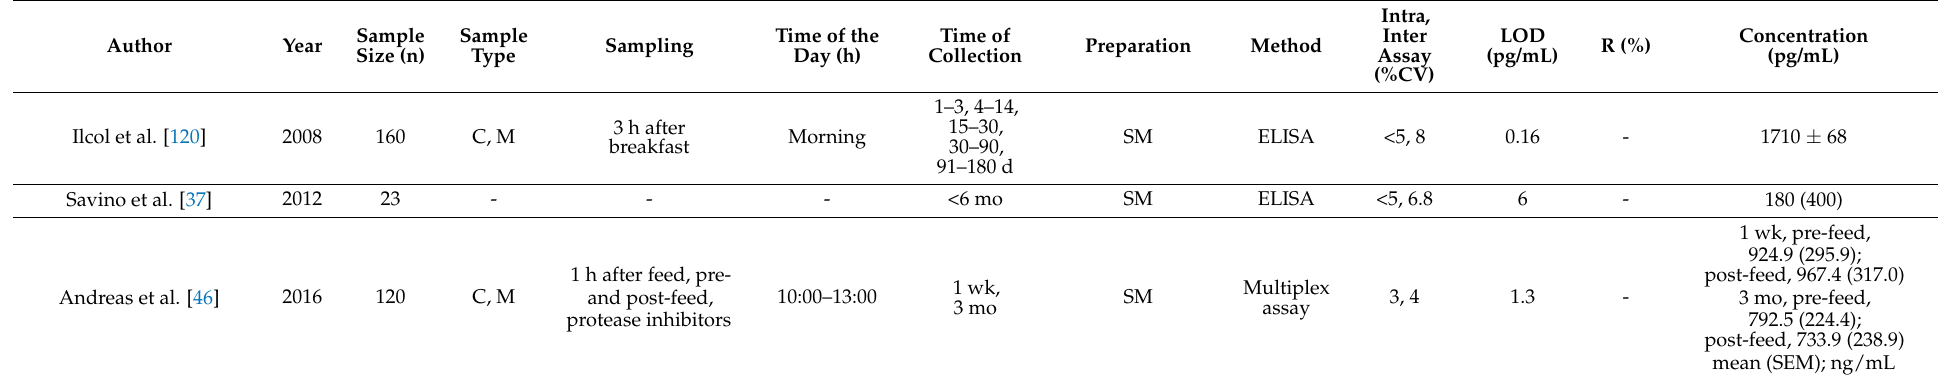
Table 5. Studies examining human milk